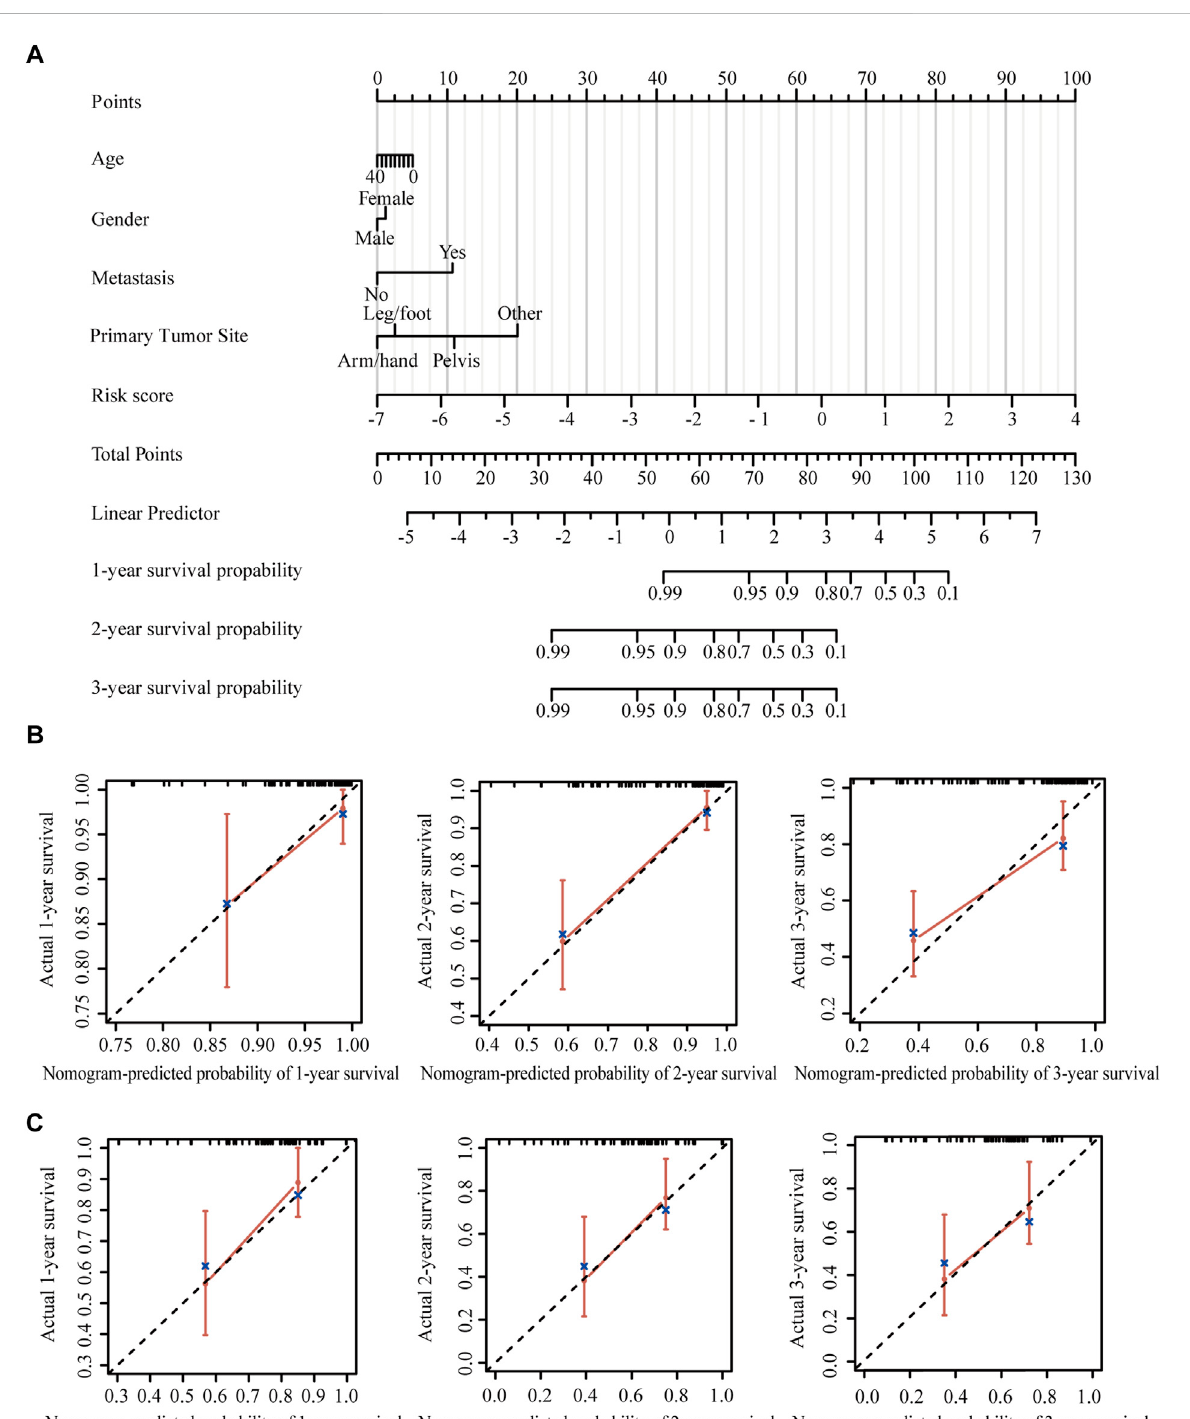
FIGURE 6 Construction and validation of the nomogram. (A) Nomogram to predict the 1-, 2-, and 3-year overall survival in patients from the TARGET dataset. (B) Calibration curves of the nomogram in patients from the TARGET dataset. (C) Calibration curves of the nomogram in patients from the GSE21257